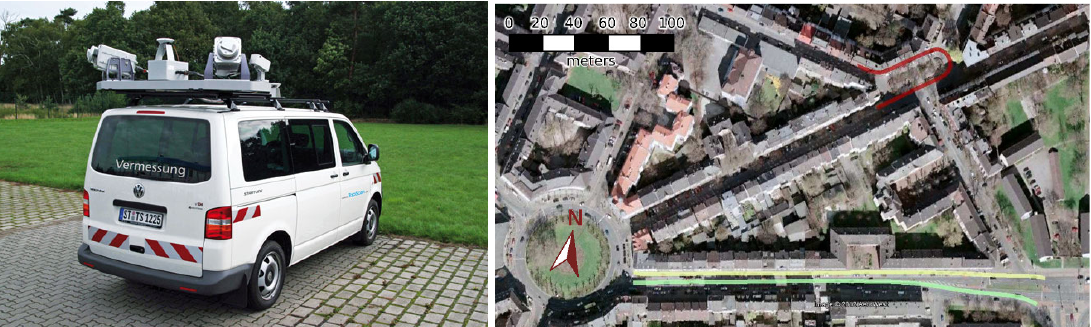
DE/BKG, GeoContent, GeoEye and